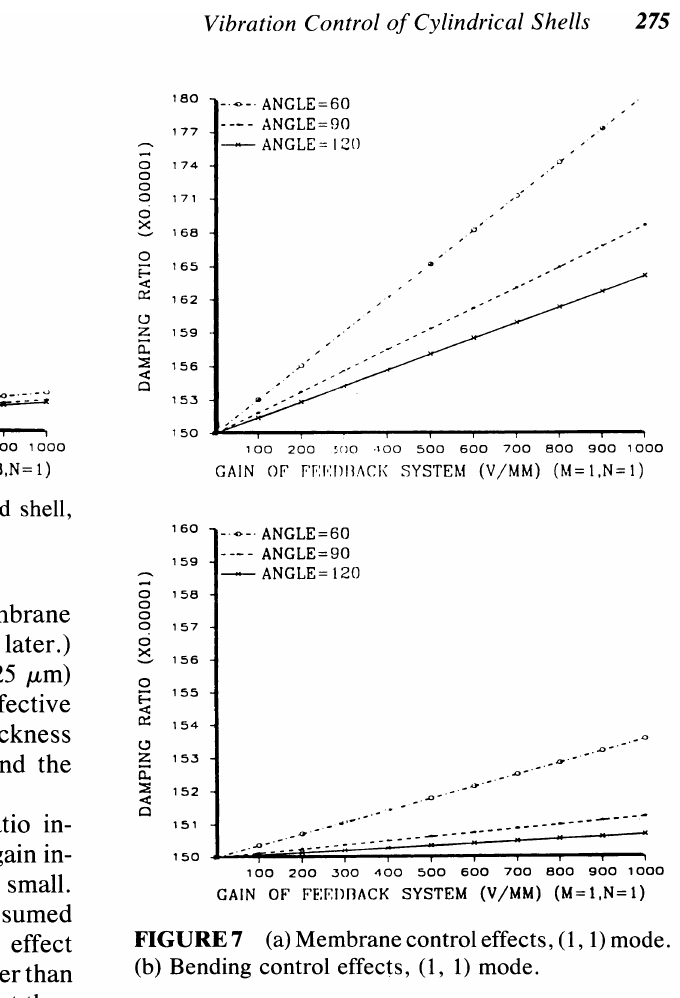
FIGURE 7 (a) Membrane control effects, (l, 1) mode. (b) Bending control effects, (1, 1)